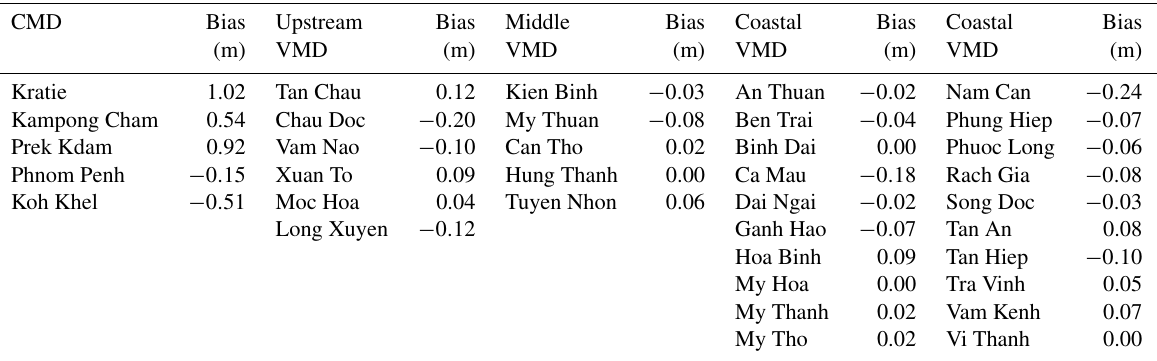
Table A1. Calculated bias for water level calibration at stations in different regions. CMD